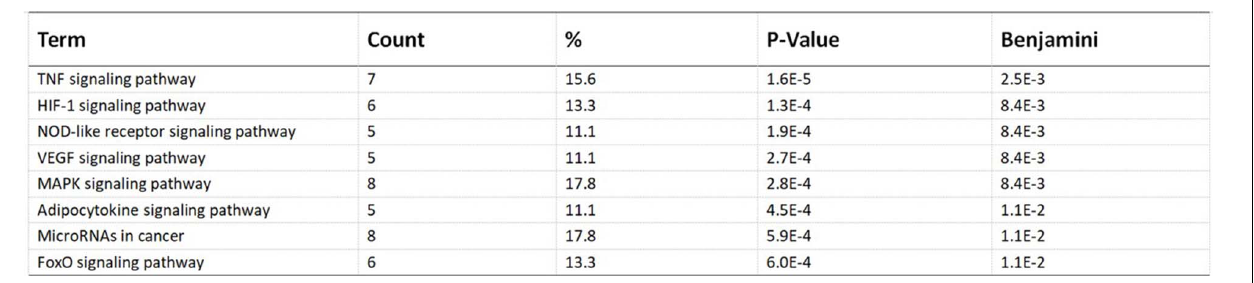
FIGURE 3 | Top eight biological pathways were selected and shown according to enrichment score. The TNF signaling pathway was significantly